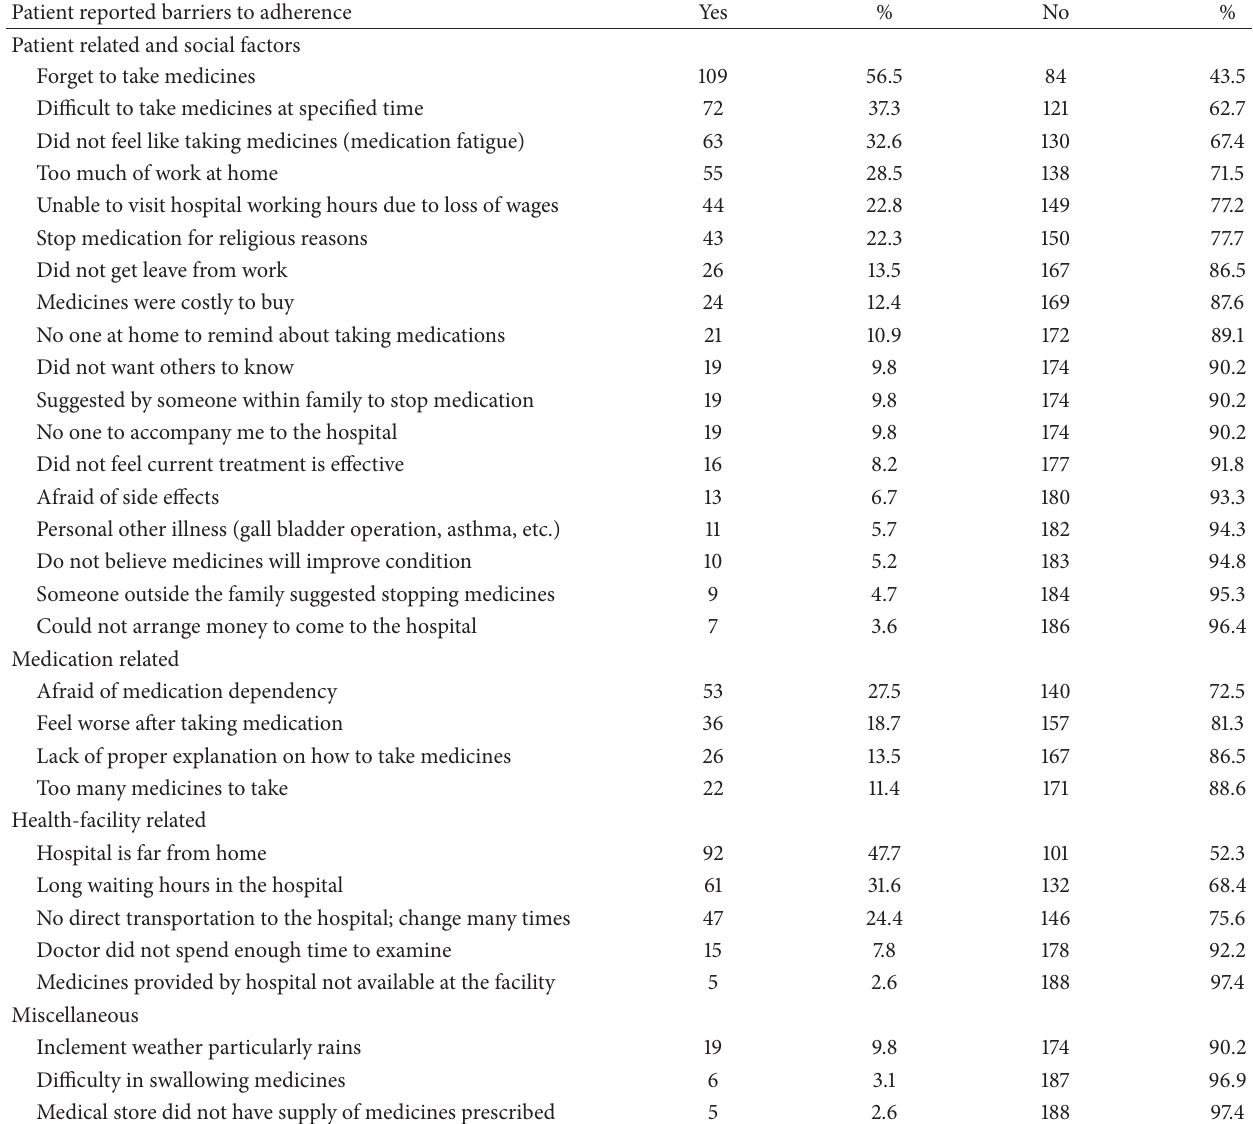
Table 11: Patient reported barriers to adherence of prescribed treatment ( 𝑁 = 193